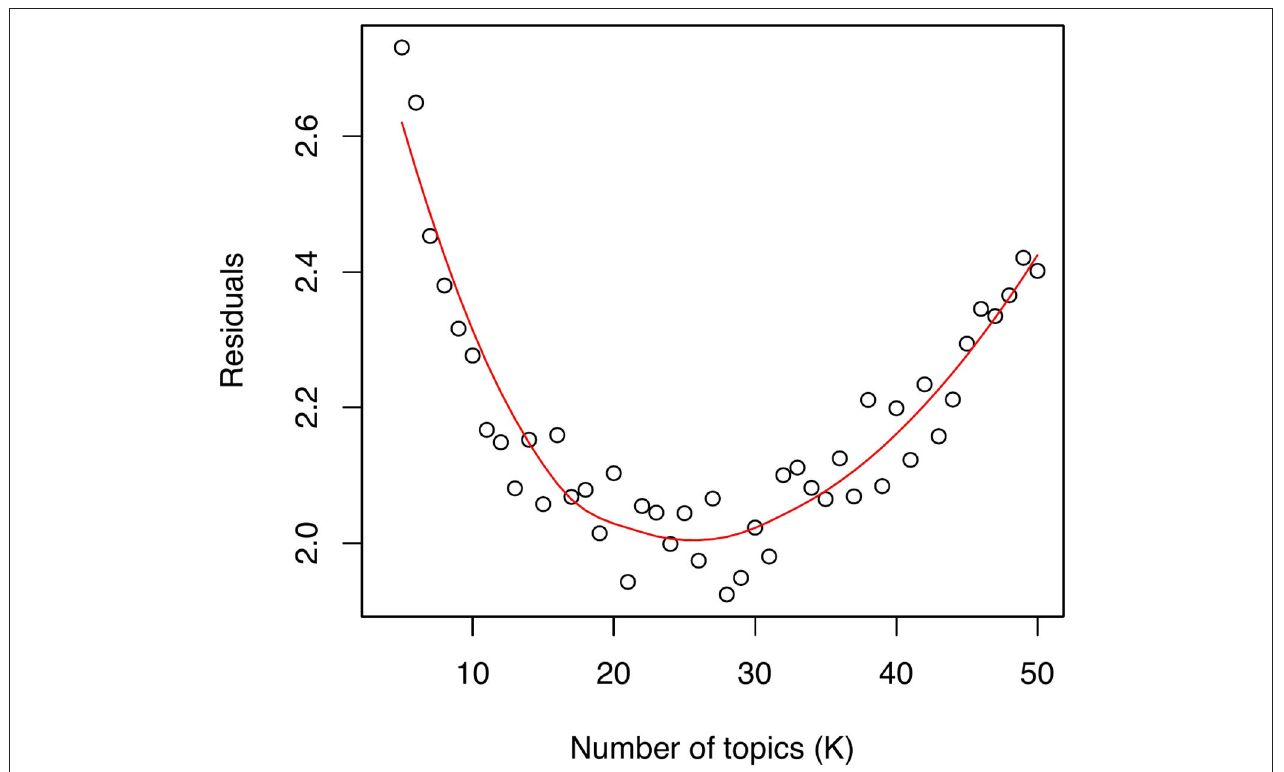
FIGURE 1 | Diagnostic values of the residuals across the models with a value of K ranging from 5 to 50.